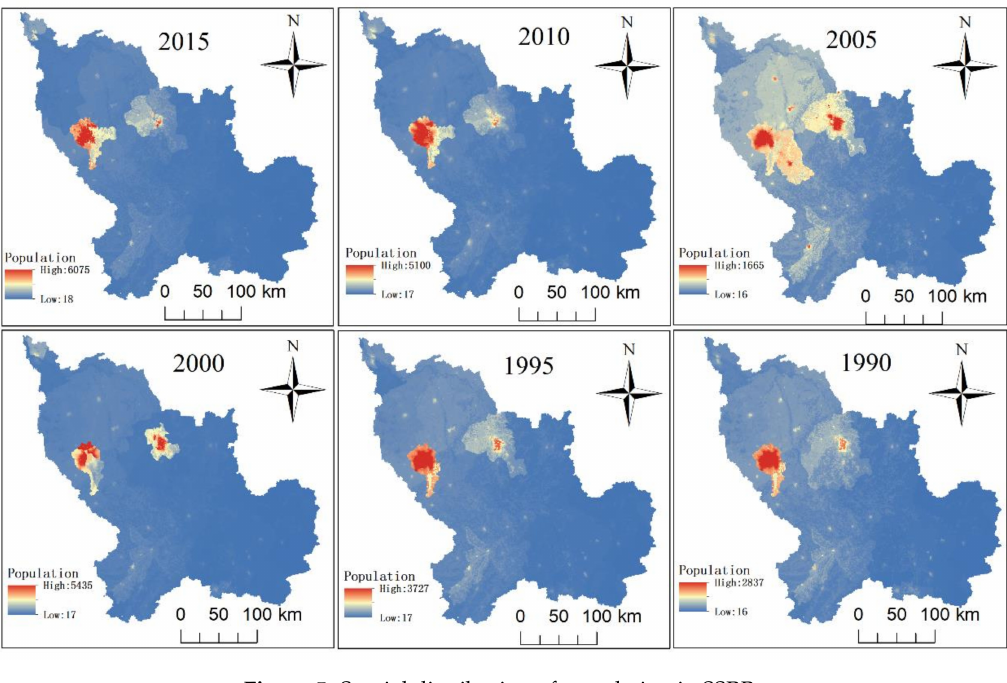
Figure 5. Spatial distribution of population in SSRB.